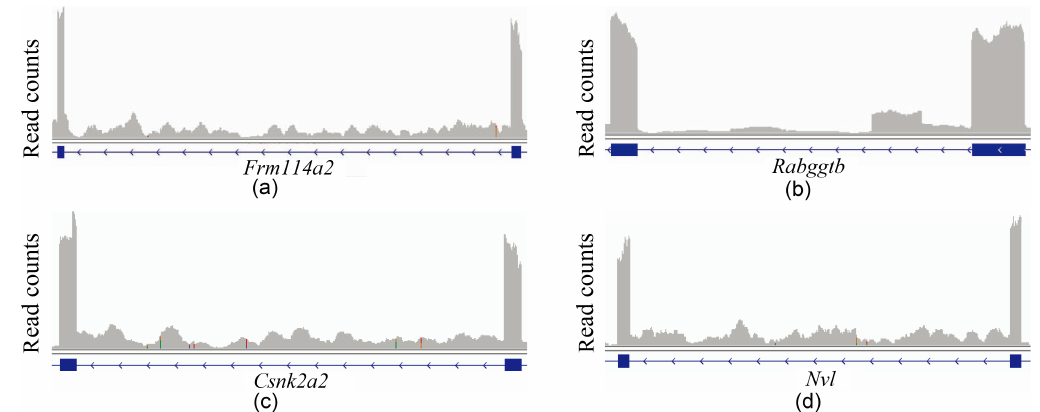
Fig. 4 Illustration of examples of retained introns detected by DeepRetention on the APPPS1 dataset. These retained introns are not detected by iREAD and IRFinder. (a) The retained intron (chr11: 57, 499, 805—57, 505, 233) of Fam114a2 . (b) The retained intron (chr3: 153, 909, 598—153, 910, 260) of Rabggtb . (c) The retained intron (chr8: 95, 457, 488—95, 460, 071) of Csnk2a2 . (d) The retained intron (chr1: 181, 101, 635—181, 105, 071) of Nvl . The short blue box represents the exon and the blue line represents the intron.